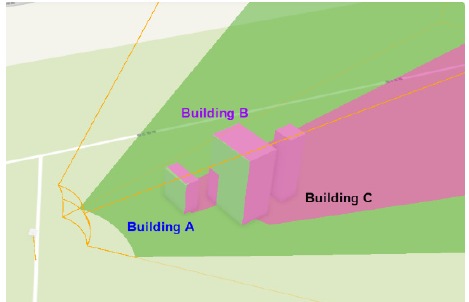
Figure 7. 3D FOV and obstruction of multiple objects.